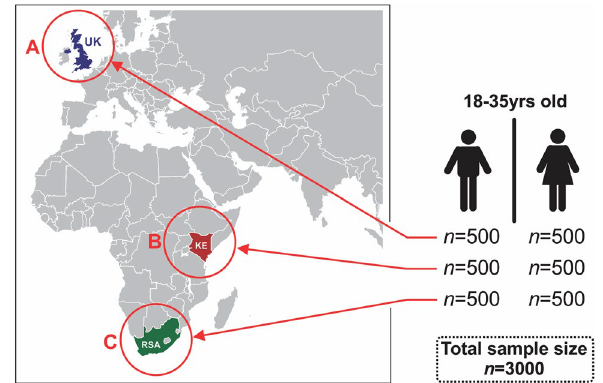
Figure 1. Geographical representation of the three countries in which the survey was conducted. KE Kenya, RSA Republic of South Africa, UK United